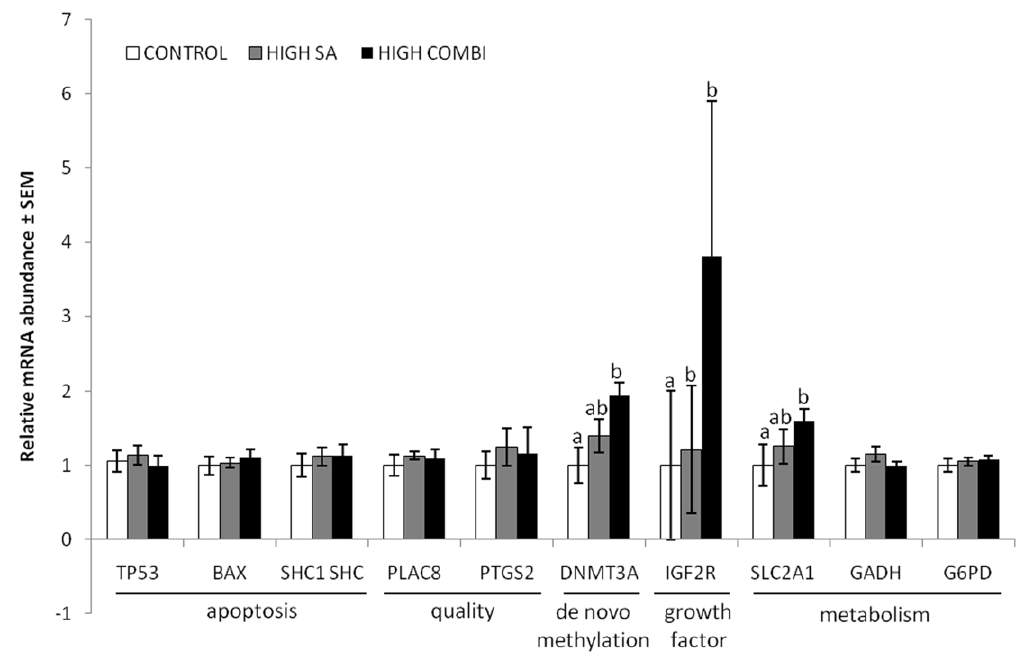
Figure 1. Expression patterns of key genes are altered in bovine blastocysts arising from oocytes matured in the presence of elevated NEFA. Blastocysts were derived from oocytes matured under control, HIGH SA and HIGH COMBI conditions (n=192; five replicates). Bars with different superscripts are significantly different between treatments with P , 0.05.